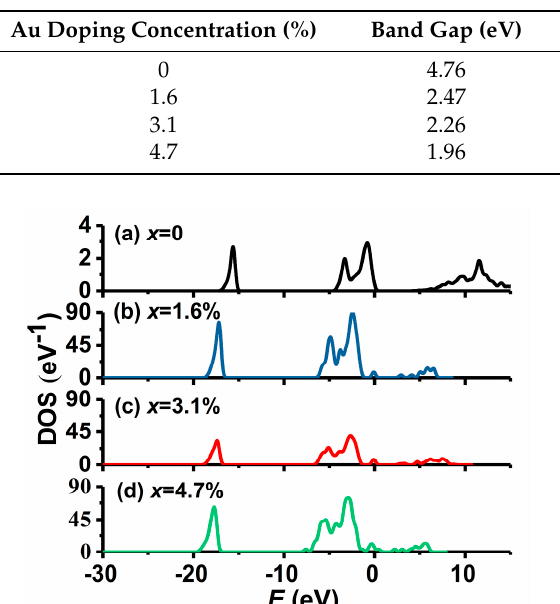
Table 2. Band gaps of an undoped MgO crystal and three Au-doped MgO crystals with doping concentrations of 1.6%, 3.1%, and 4.7%.